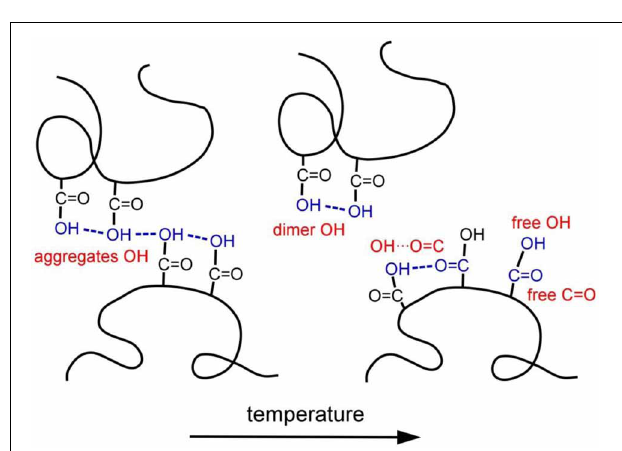
FIGURE 8 | Schematic illustration of the change in hydrogen-bonds structure in PHEMA induced by temperature.